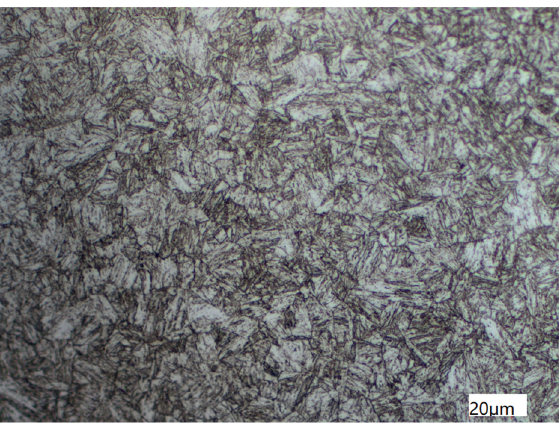
Figure 5. Metallographic Structure of Tubing Observed by Axio Scope A1.